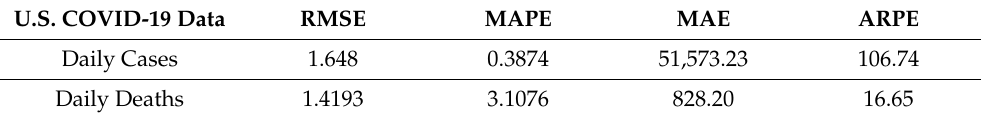
Table 11. Results from system of IG(a,b) OU model.